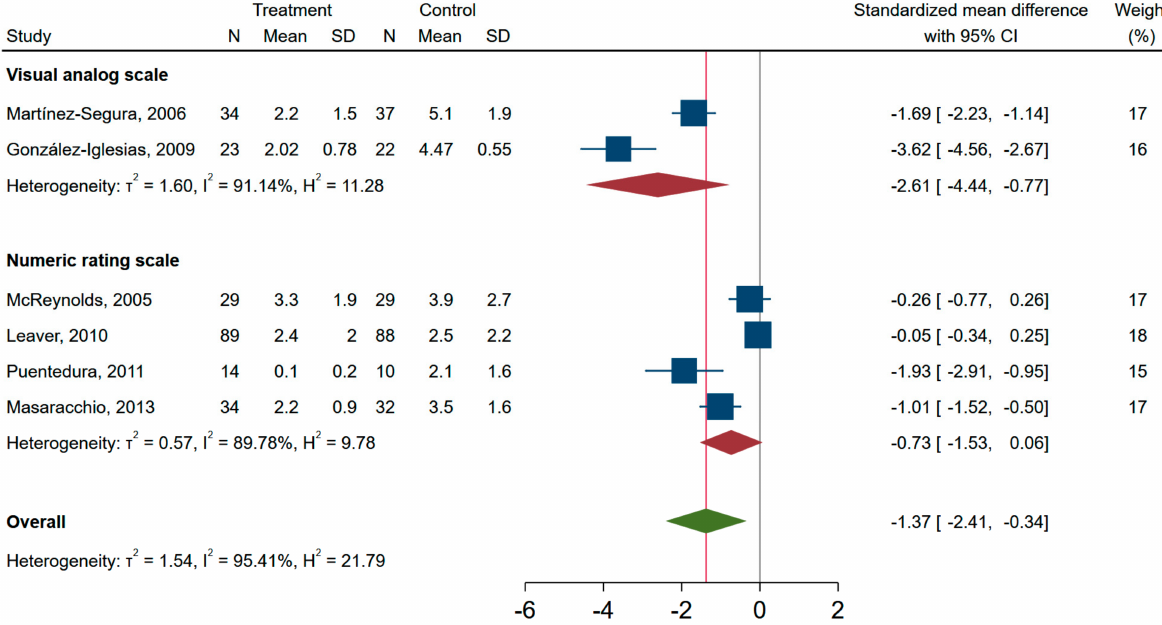
Figure 3. Pain intensity outcomes in randomized controlled trials of effectiveness of spinal manipulative therapy for acute neck pain with subgroups according to type rating scale used for assessment ( n = 441). Between group differences at first assessment after the